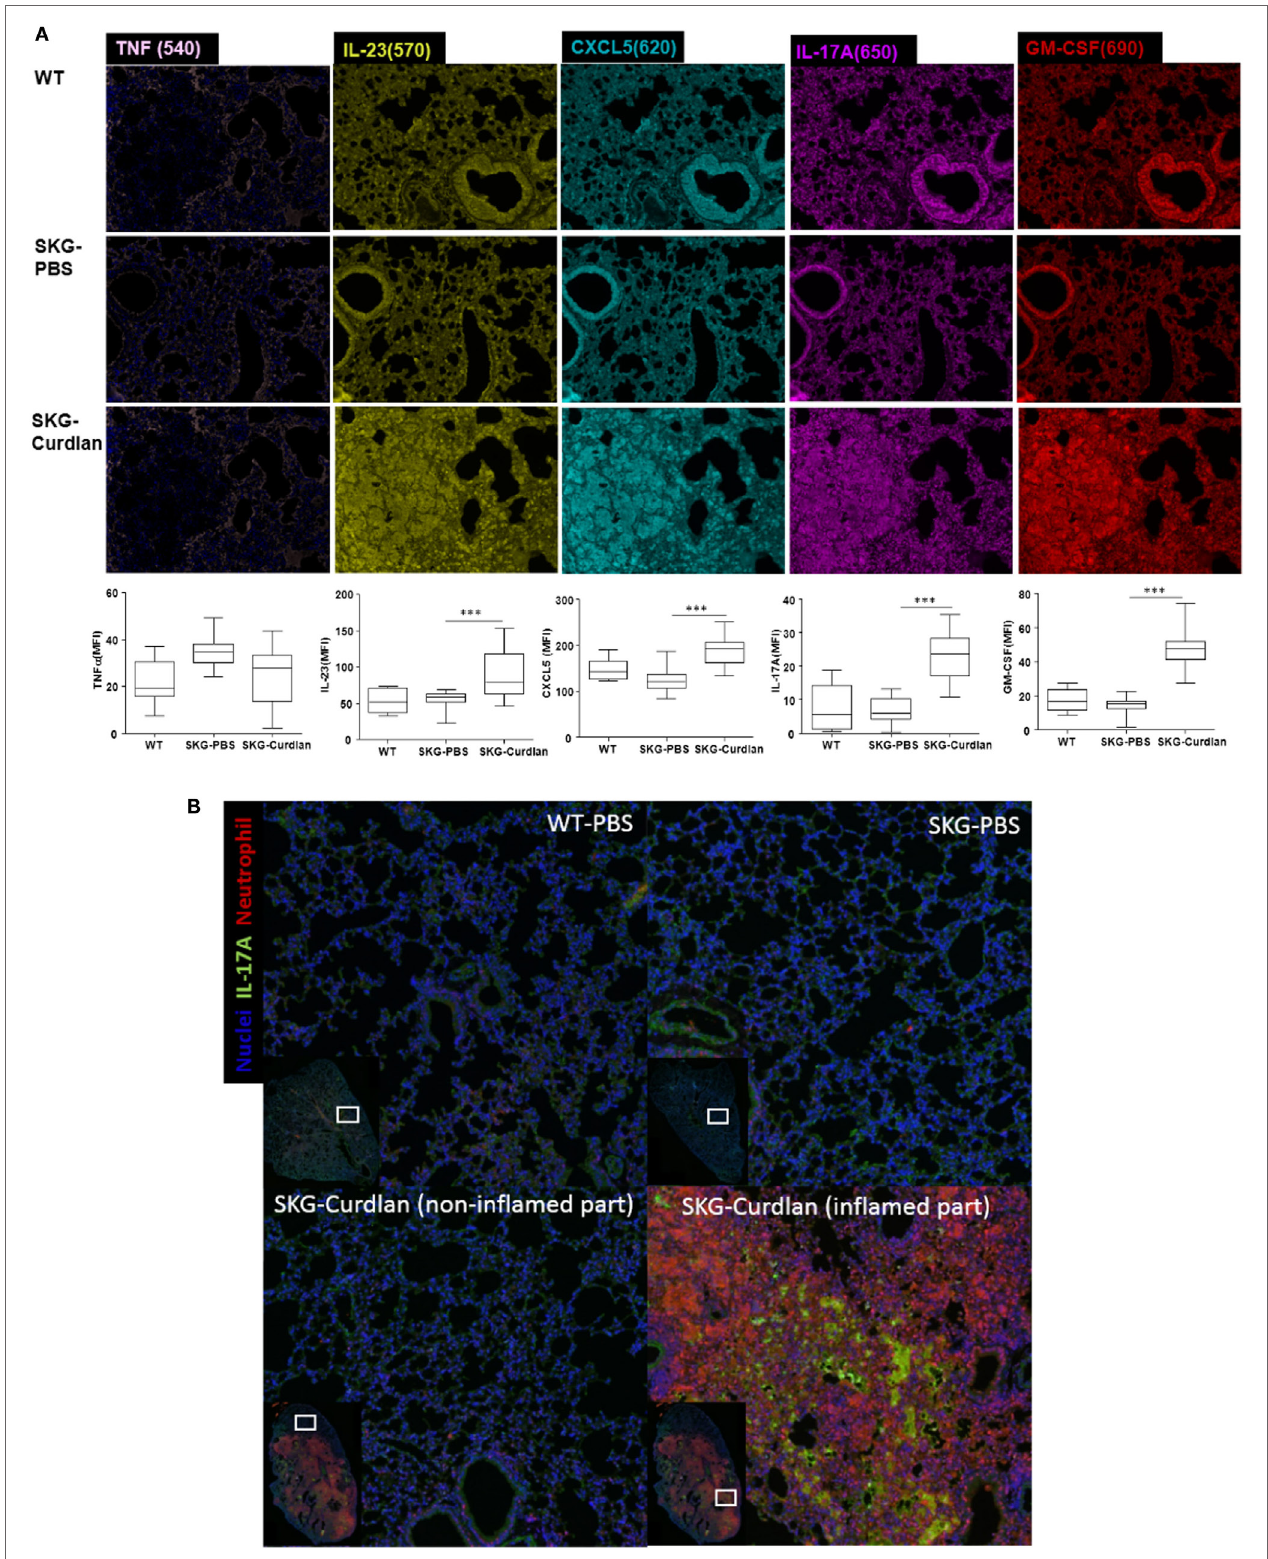
FigUre 5 | Opal multiplexed immunofluorescent images of lung tissues. (a) IL-23 + , CXCL5 + , IL-17A + , GM-CSF + , and TNF- α + cells in curdlan-treated SKG mice. (B) IL-17A + cells and neutrophils in inflamed lesion of the lungs of curdlan-treated SKG